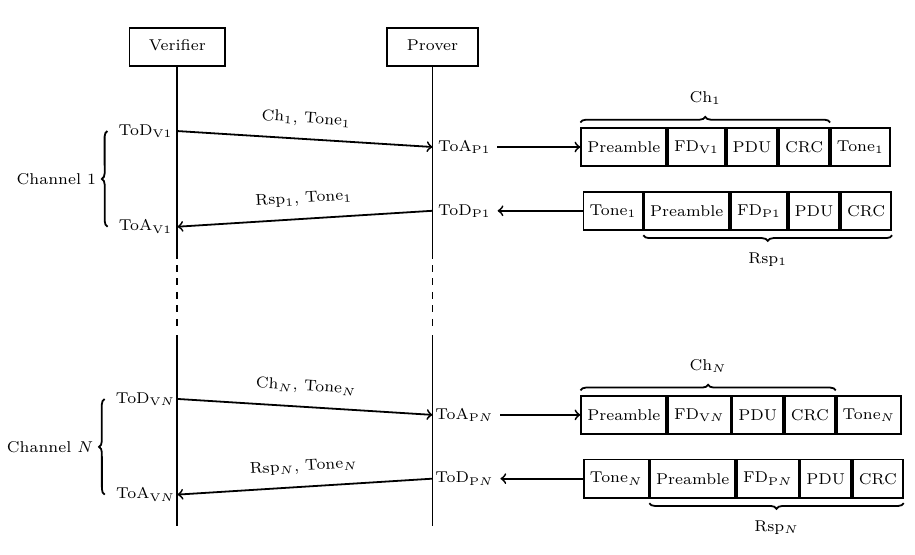
Figure 4: The distance bounding (or ranging) stage of our